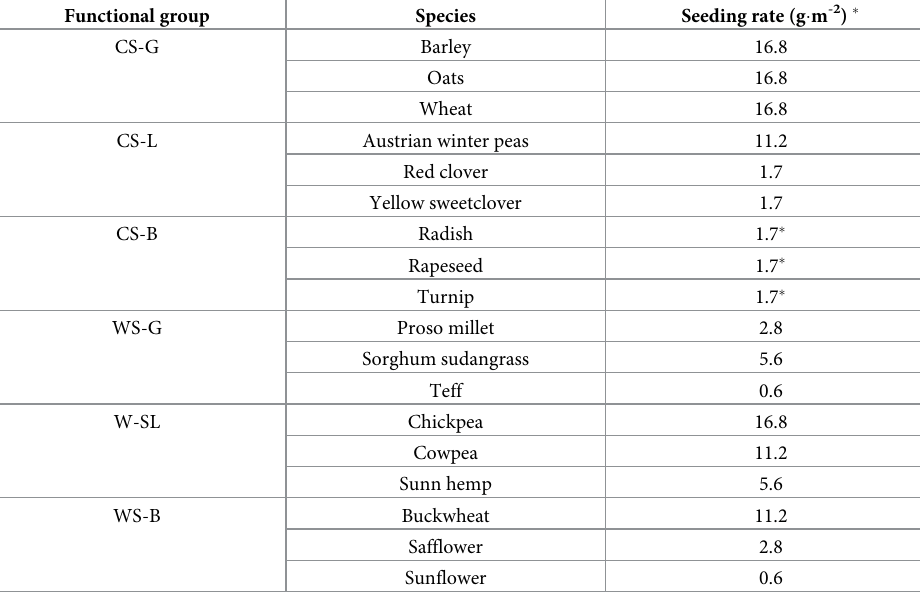
Table 4. Seeding rates used for each cover crop species in pure stands. Functional